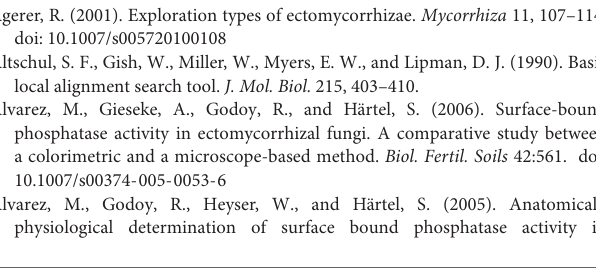
TABLE S2 | Results of the nlme-Model for the IGTs in Bad Brückenau (BBR), Mitterfels (MIT), Vessertal (VES), Conventwald (CON), and Lüss (LUE), including only the last sampling date after 18 months of exposure ( n = 5). Level of significance: *** p < 0.001, ** p < 0.01, * p < 0.05, and + p < 0.1. TABLE S3 | Results of open and closed IGTs in Bad Brückenau (BBR), Mitterfels (MIT), Vessertal (VES), Conventwald (CON), and Lüss (LUE) during the experiment ( n = 5). Bold values represent statistically significant differences (Tukey test) between open and closed IGTs at the respective forest and sampling date. TABLE S4 | Results of control soil in Bad Brückenau (BBR), Mitterfels (MIT), Vessertal (VES), Conventwald (CON), and Lüss (LUE) after 18 months of exposure ( n = 5). Superscript letters indicate results of the Tukey test, highlighting differences between forest